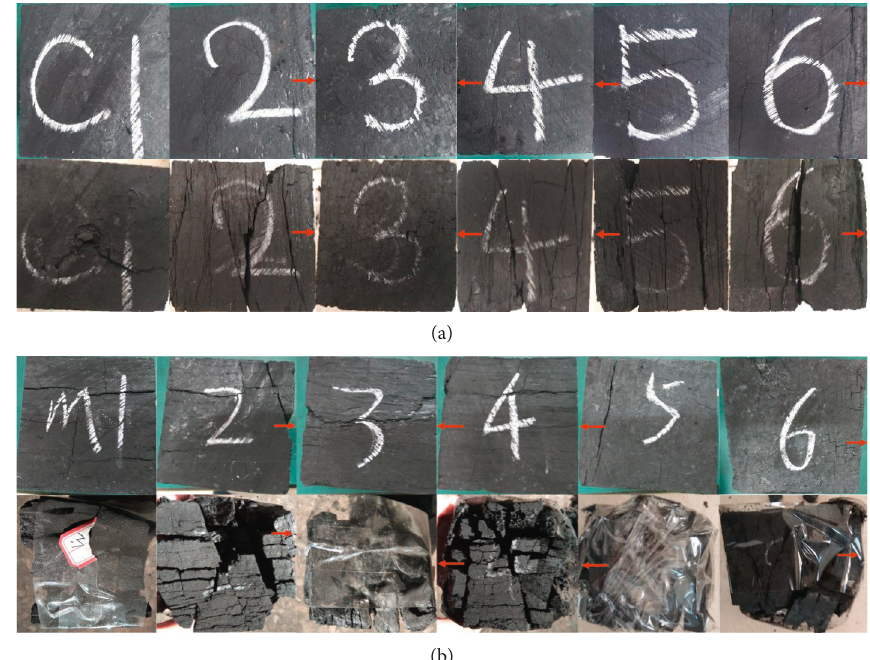
Figure 4: Comparison of nonbursting sample and bursting sample before and after testing (previous row: pretest photos; next row: post-test photos; The red arrow: the direction of unloading): (a) nonbursting coal sample (sample C); (b) bursting coal sample (sample